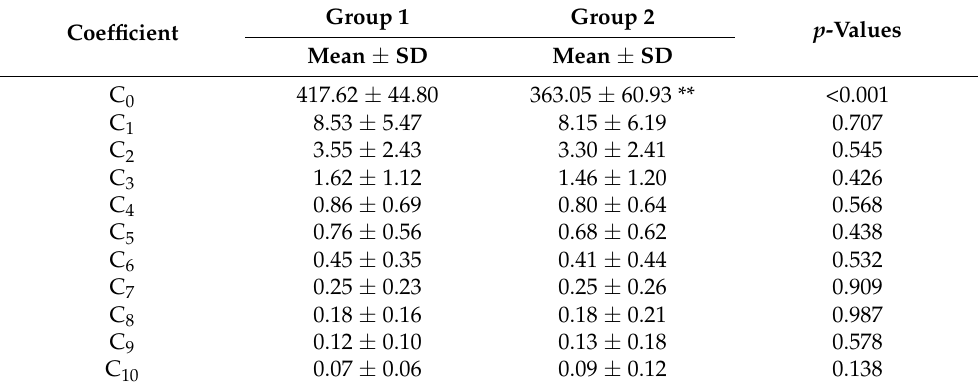
Table 3. Coefficients (C 0 –C 10 ) of discrete-time Fourier series for the digital volume pulse signals from Group 1—healthy elderly subjects—and Group 2—diabetic patients. Group 1 Group Coefficient